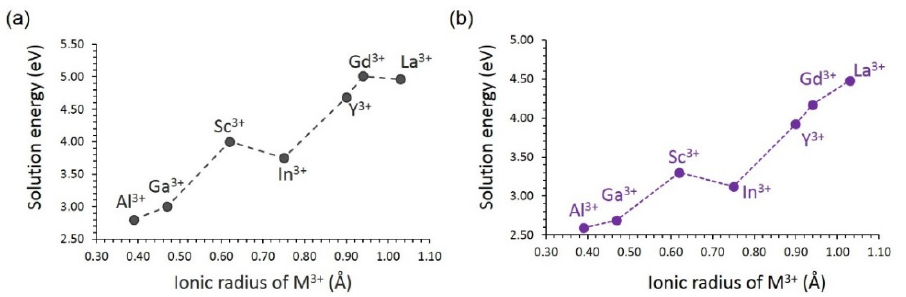
Figure 8. Solution energy of M 2 O 3 forming interstitials with respect to the M 3+ ionic radius in ( a ) LiVSi 2 O 6 and ( b ) NaVSi 2 O 6 .